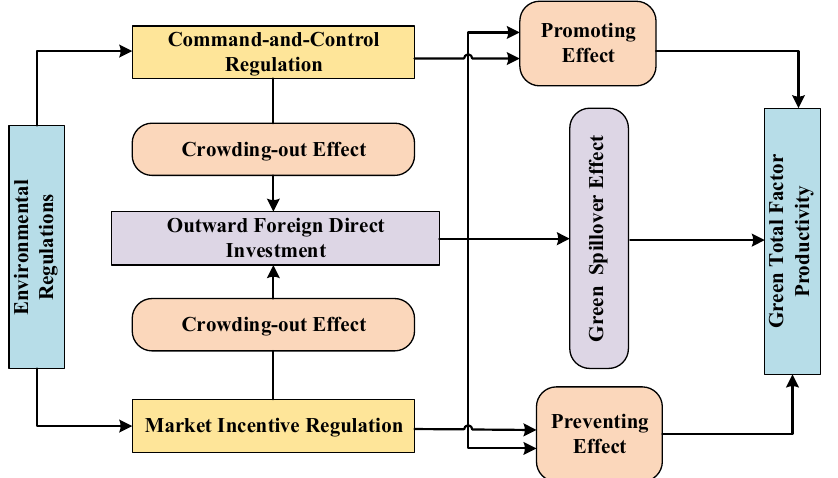
Figure 1. The impacting mechanism of ERs on GTFP through OFDI.